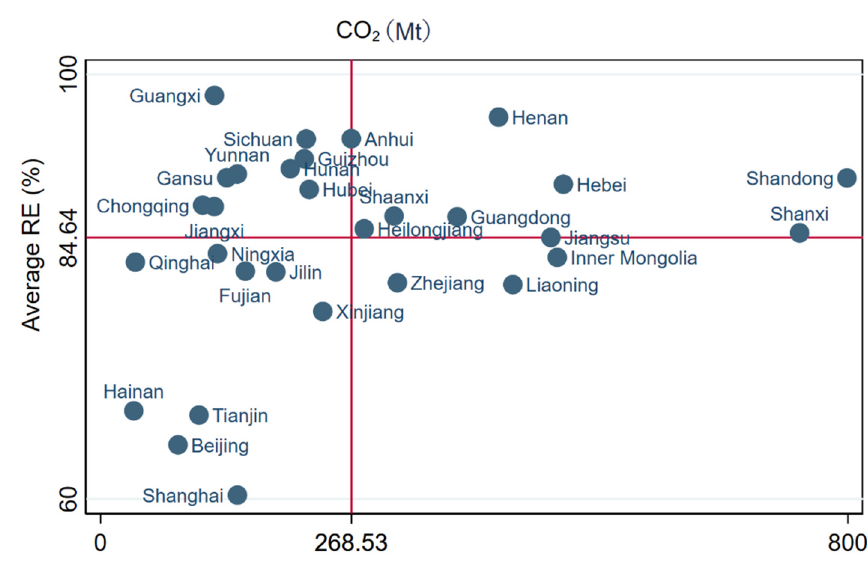
Figure 7. Group division based on the RE and CO 2 emissions of China’s 30 provinces.